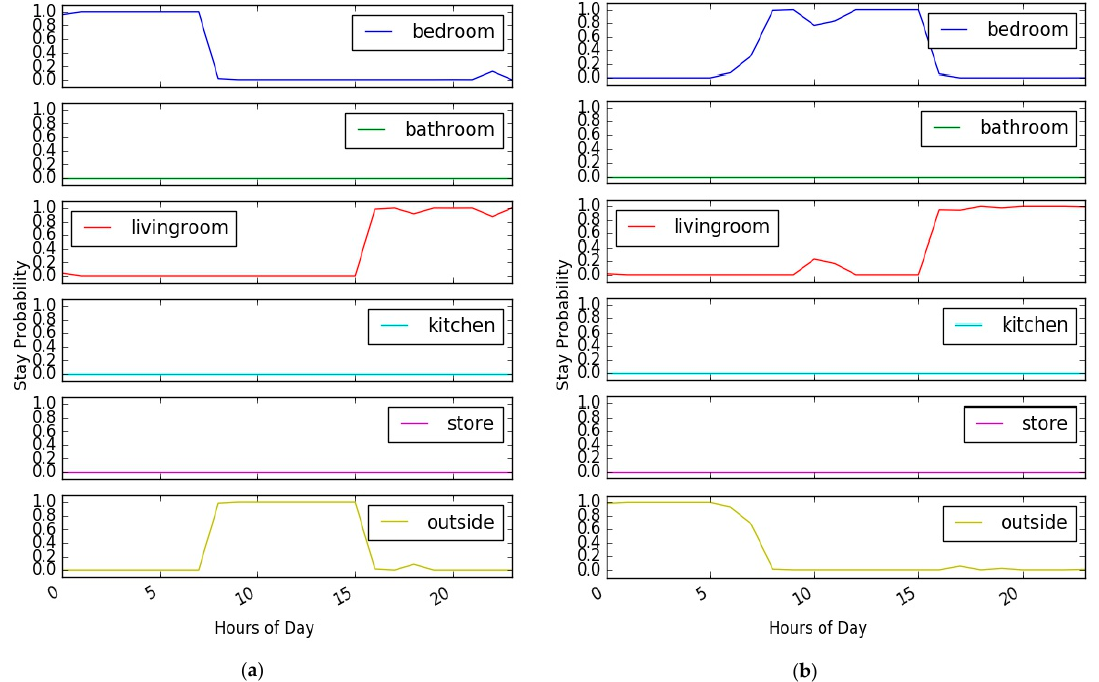
Figure 8. Learned normal behaviour- synthetic datasets. ( a ) Profile A; ( b ) Profile B.